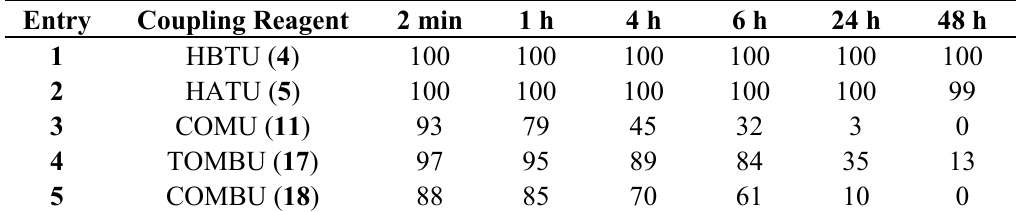
Table 2. Closed vials hydrolytic stability of uronium/aminium-type coupling reagents in DMF [a]